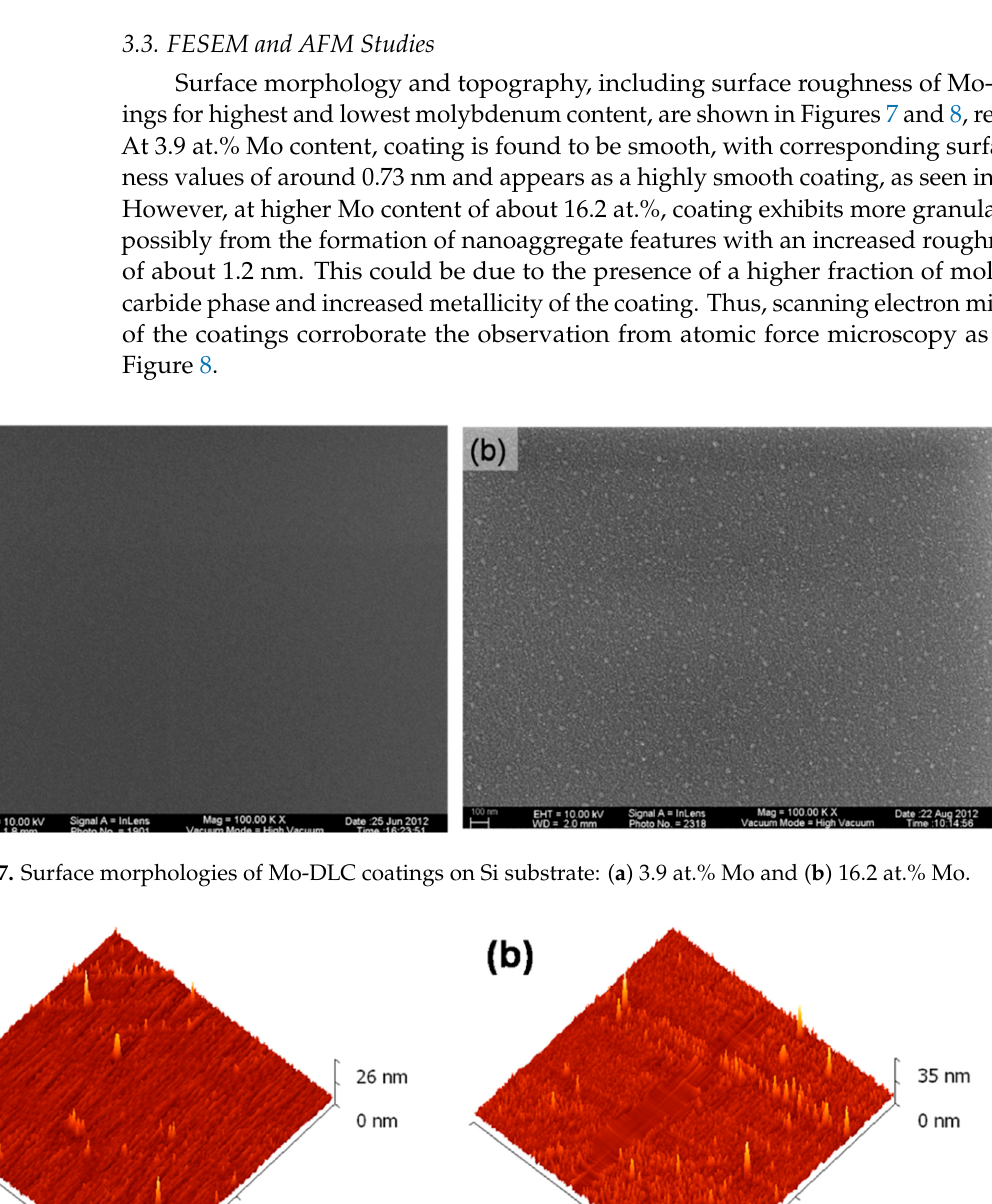
Figure 6. XRD patterns of Mo-DLC coatings on Si substrate: ( a ) Si substrate, ( b ) 3.9 at.% Mo, and ( c ) 16.2 at.% Mo.